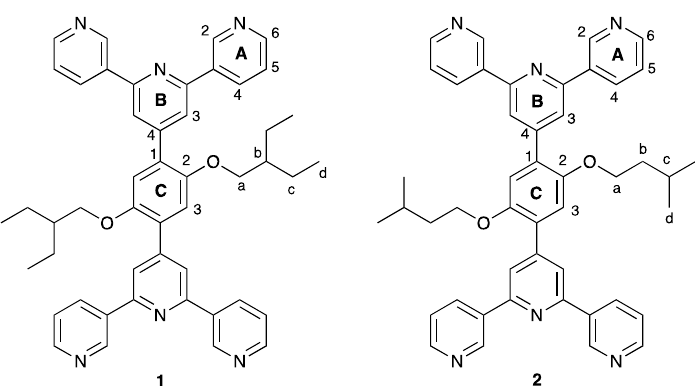
Scheme 4. Structures of ligands 1 and 2 with atom labels used for NMR spectroscopic